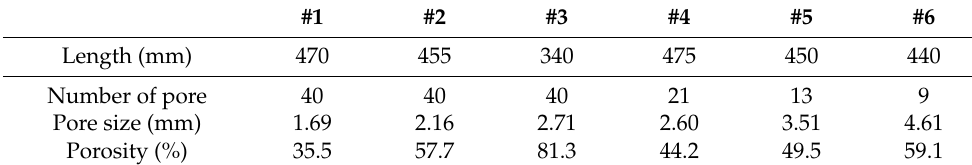
Table 1. Specifications of porous tubes.